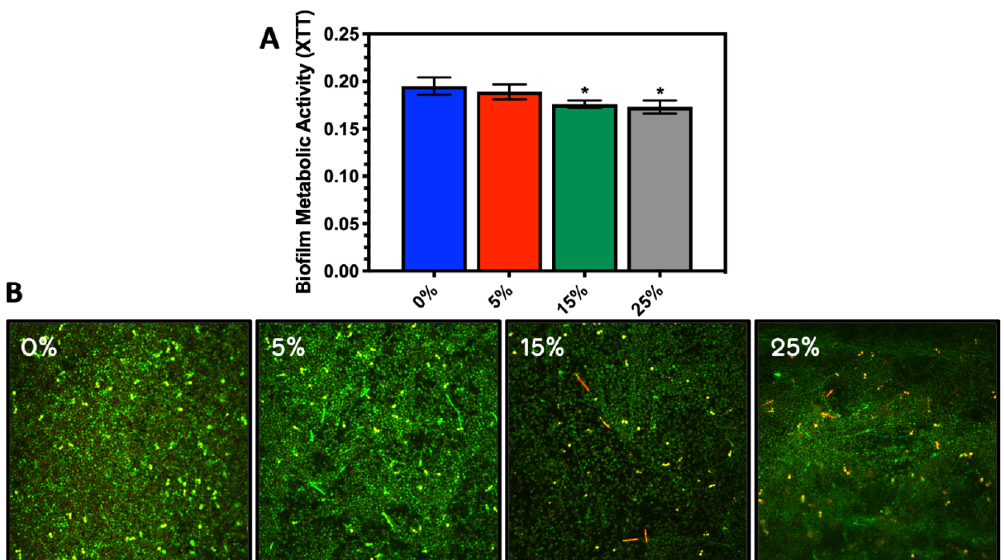
Figure 1. ( A ) Metabolic activity of the biofilms as measured by XTT. Average values and standard deviations were averaged from 6 replicate disks for each condition and ( B ) Confocal microscopic images of Candida (AD1) biofilm of on 0, 5, 15, and 25% phosphated PMMA using Live/Dead staining. * Statistically significant reduction in metabolic activity compared to PMMA control (0% Phosphate).